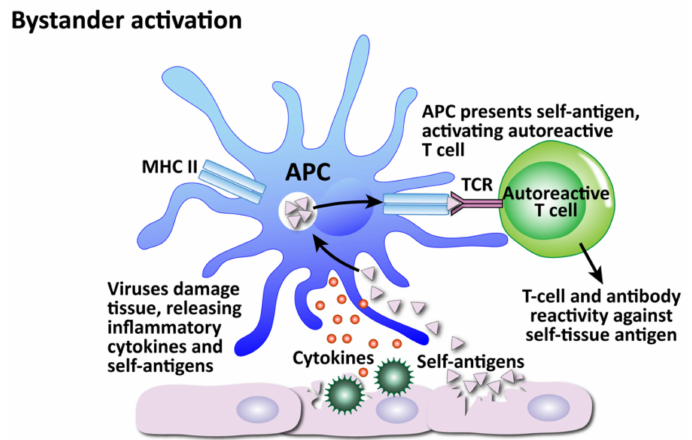
Figure 12. How viruses can induce autoimmunity through bystander activation. Excessive non- specific antiviral immune responses lead to the release of inflammatory cytokines and self-antigens. Self-antigens are presented to autoreactive T cells, which attack the innocent “bystander”